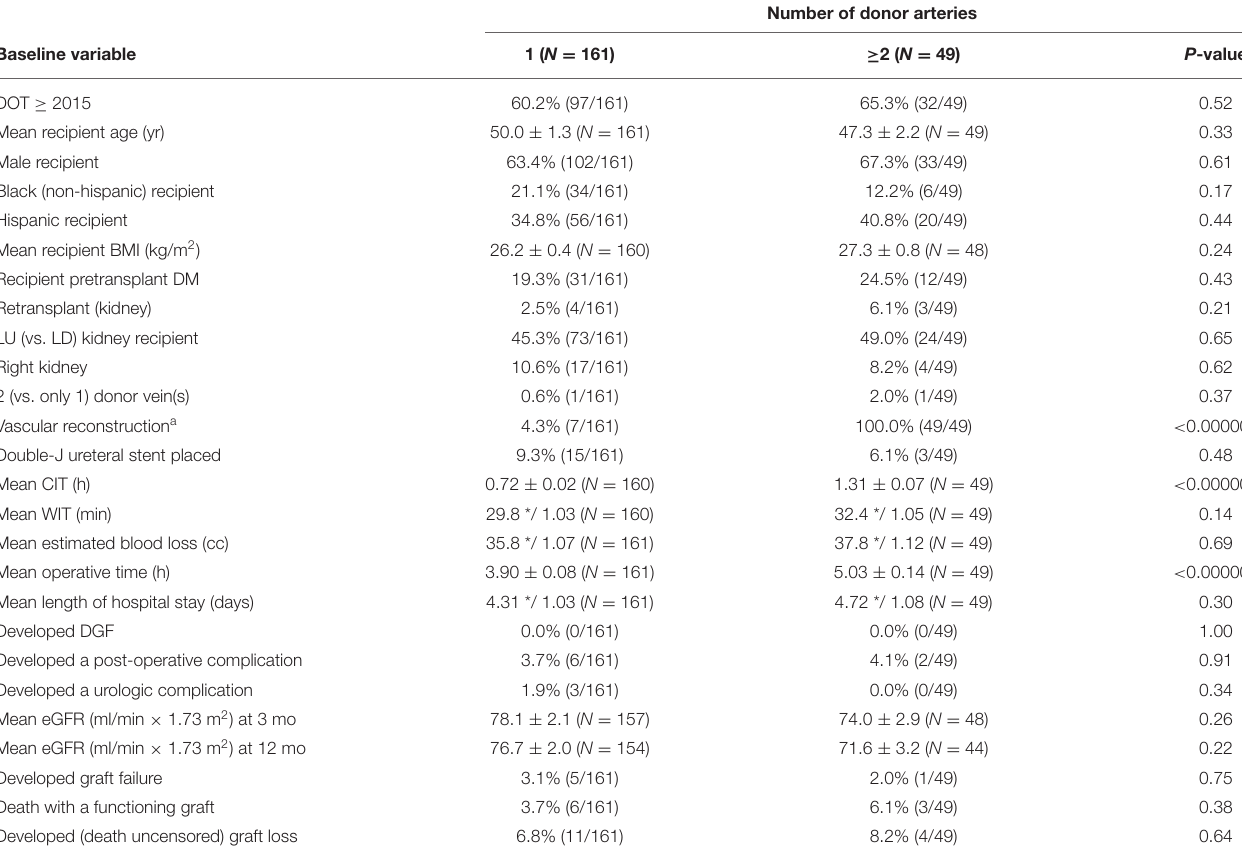
TABLE 1B | Associations of selected baseline and clinical outcome variables with number of donor arteries (1 vs. ≥